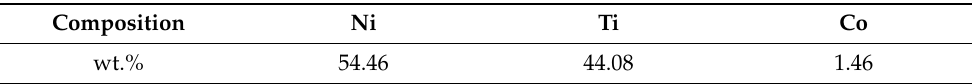
Table 1. Chemical composition of the fabricated SMA